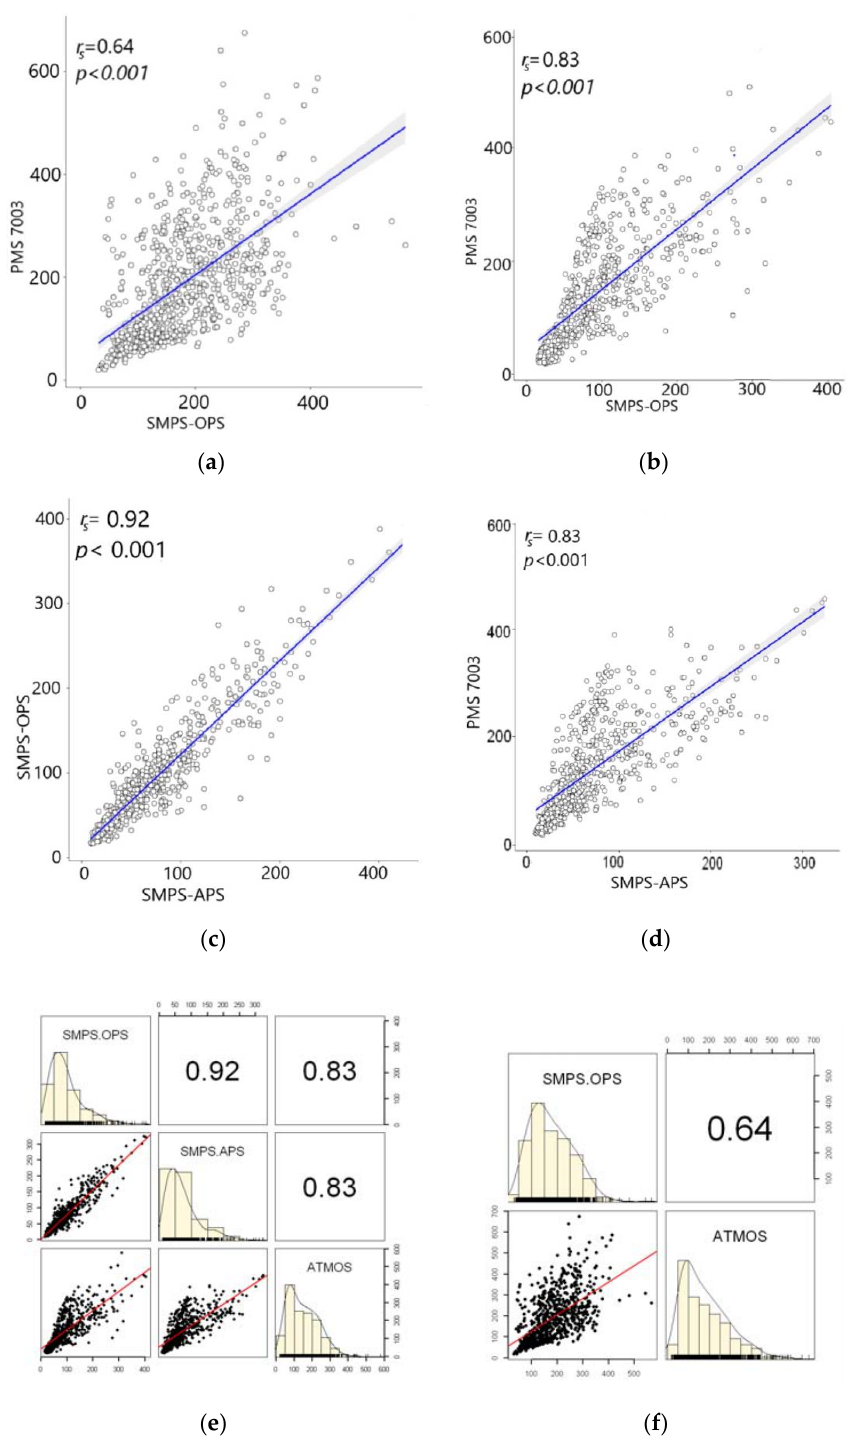
Figure 5. Scatter plots for measured PM 10 between ( a ) SMPS–OPS and Atmos or PMS 7003 at the